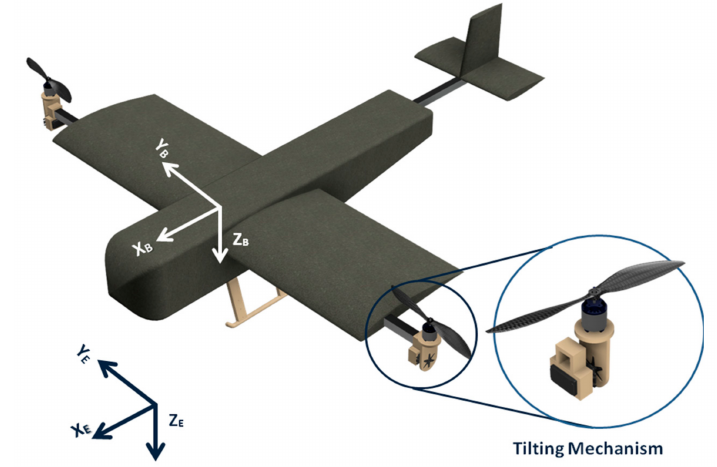
Figure 2. Isometric view of hybrid